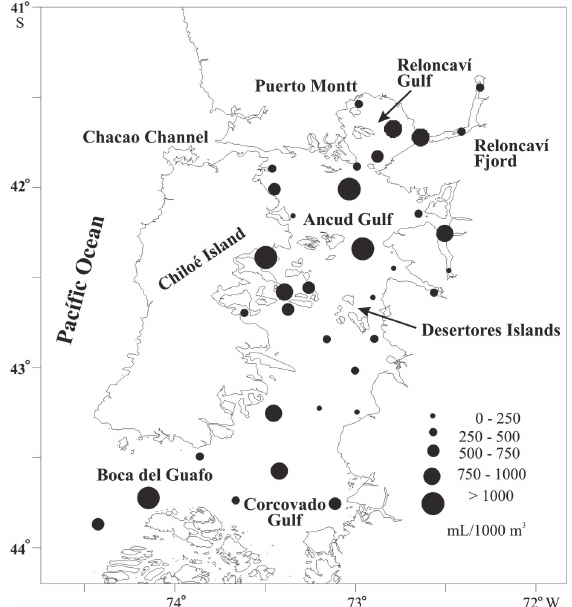
Fig . 3. – Geographic distribution of zooplanktonic